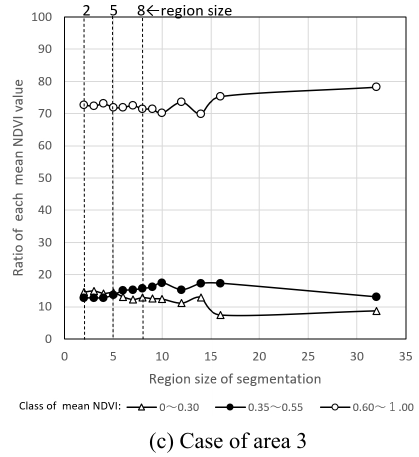
Figure 7. The change in the distribution tendency of the average NDVI value within each segment as region size changes